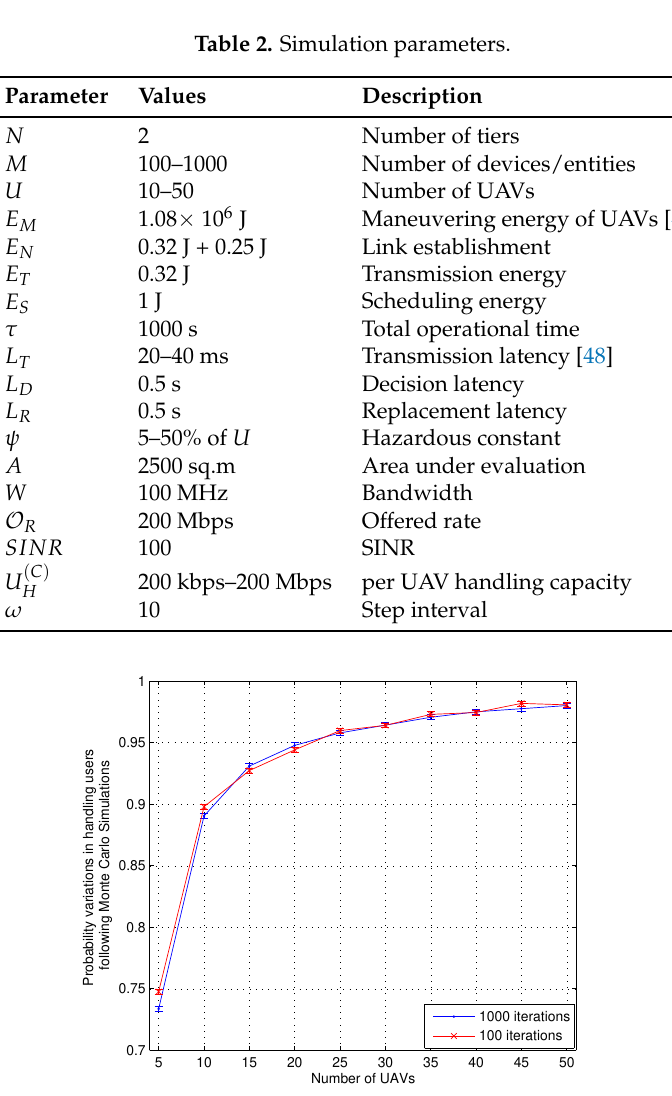
Figure 4. Probability variations for Monte-carlo based simulations vs. Number of